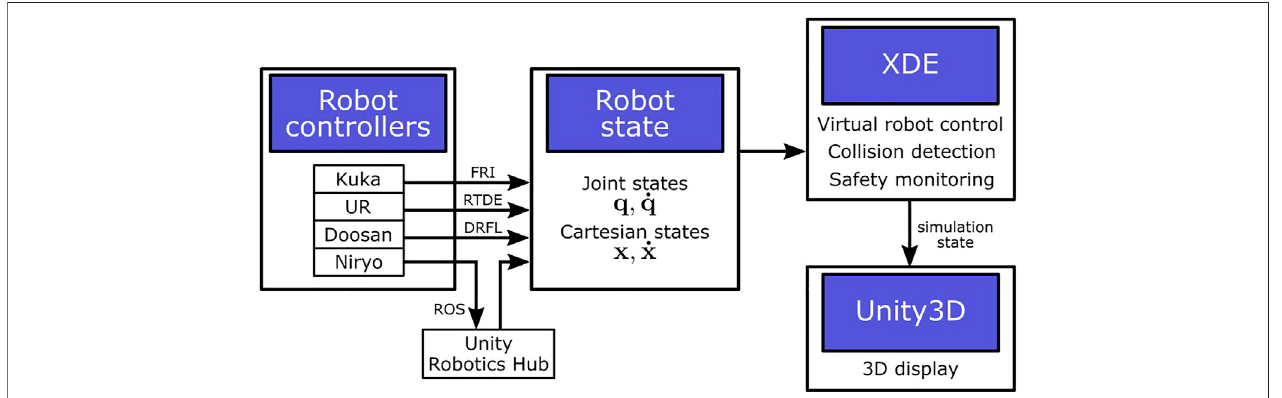
FIGURE2| Architecturefocusonrobotsdigitaltwins.RobotsstateisaccessedfromrobotcontrollersinrealtimeandsenttotheXDEphysicsenginetoprocessin the physics simulation, before sending the simulation state to Unity3D for